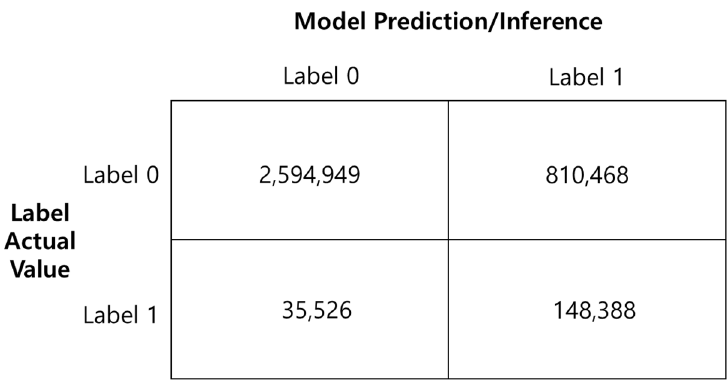
Figure 16. The confusion matrix of evaluation result using binary classification model.